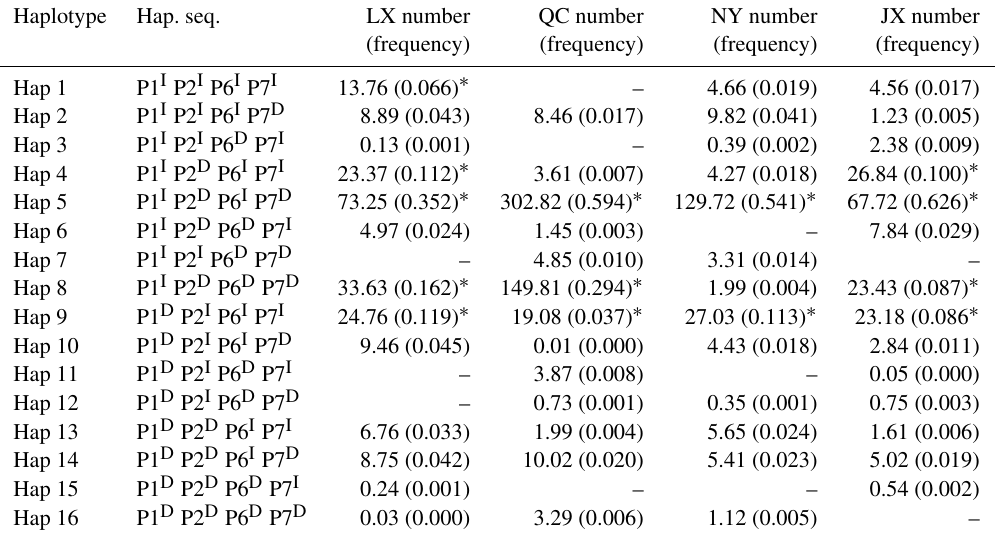
Table 4. Haplotypes and their frequencies of four indels in four Chinese cattle breeds. Haplotype